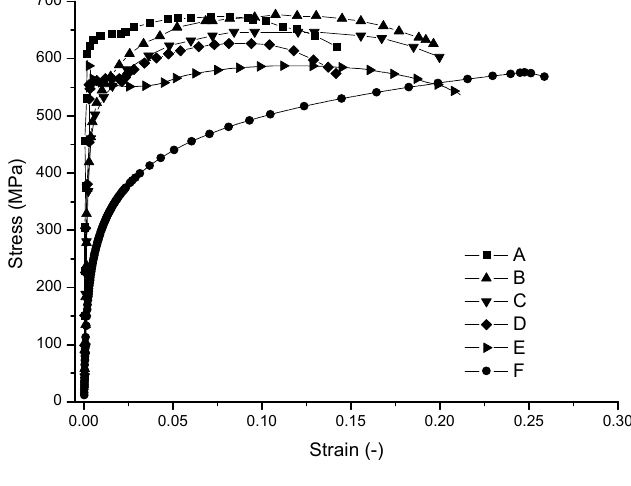
Figure 2. SEM micrographs from ( a ) straight stretch, ( b ) extrados , ( c ) extrados tempered at 600 °C, and ( d ) straight stretch normalized at 900 °C.